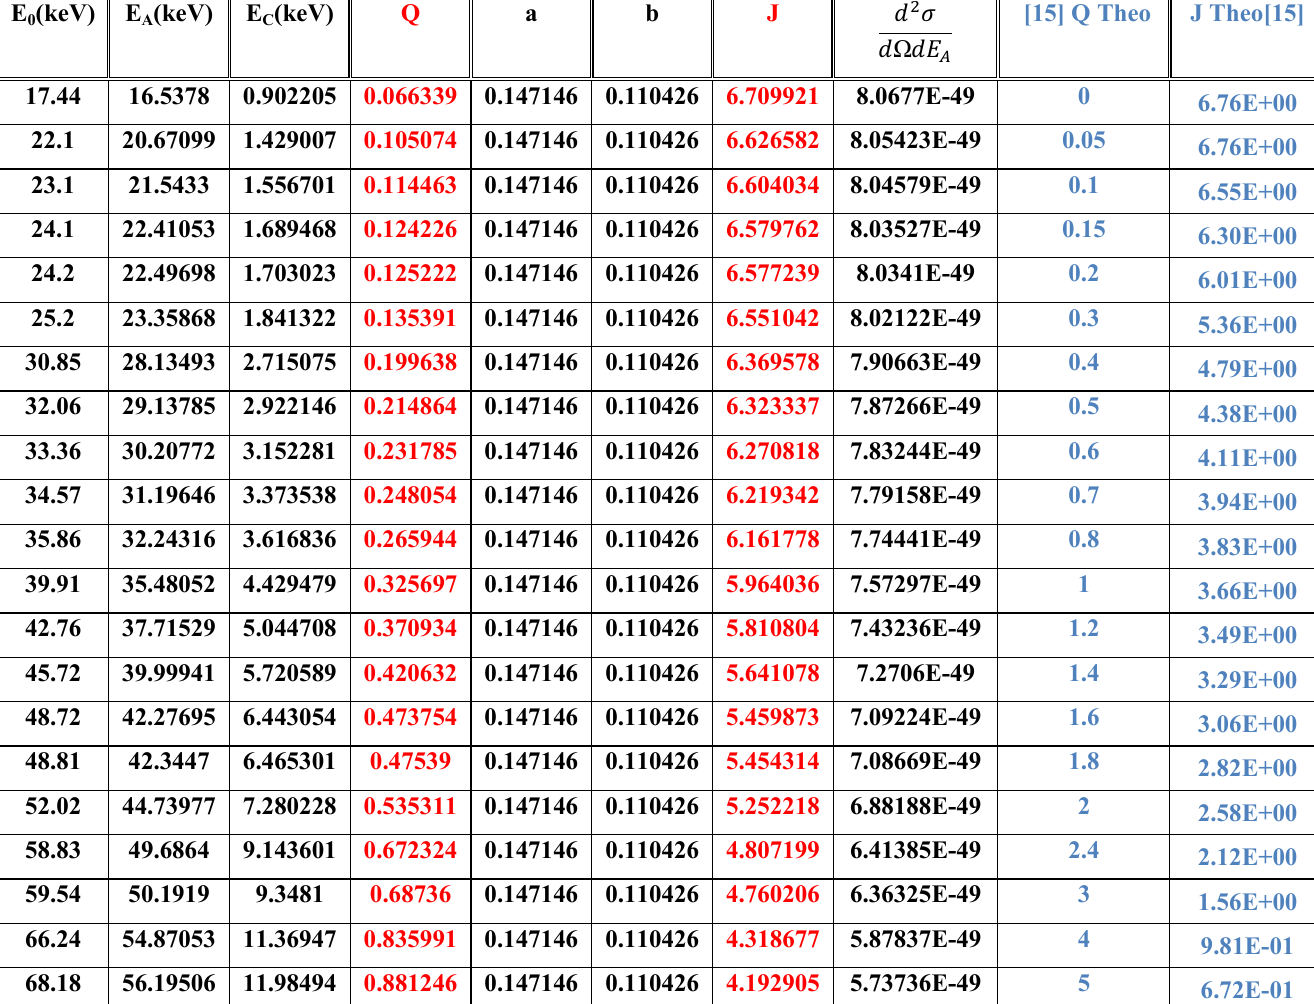
Table 2: Compton profile and double-differential cross section of doppler broadening for ( 30